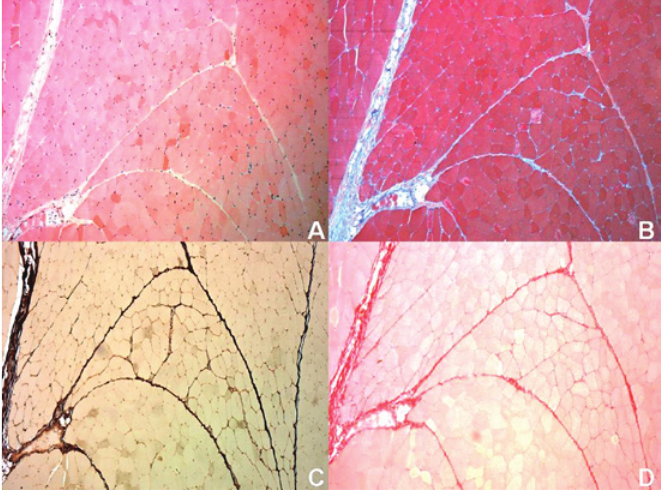
FIGURE 2 – Micrographs of histological sections of the rectus abdominis muscle stained with ( A ) H&E; ( B ) Masson’s trichrome; ( C ) reticulin; and ( D ) picrosirius red. Magnification 100x.